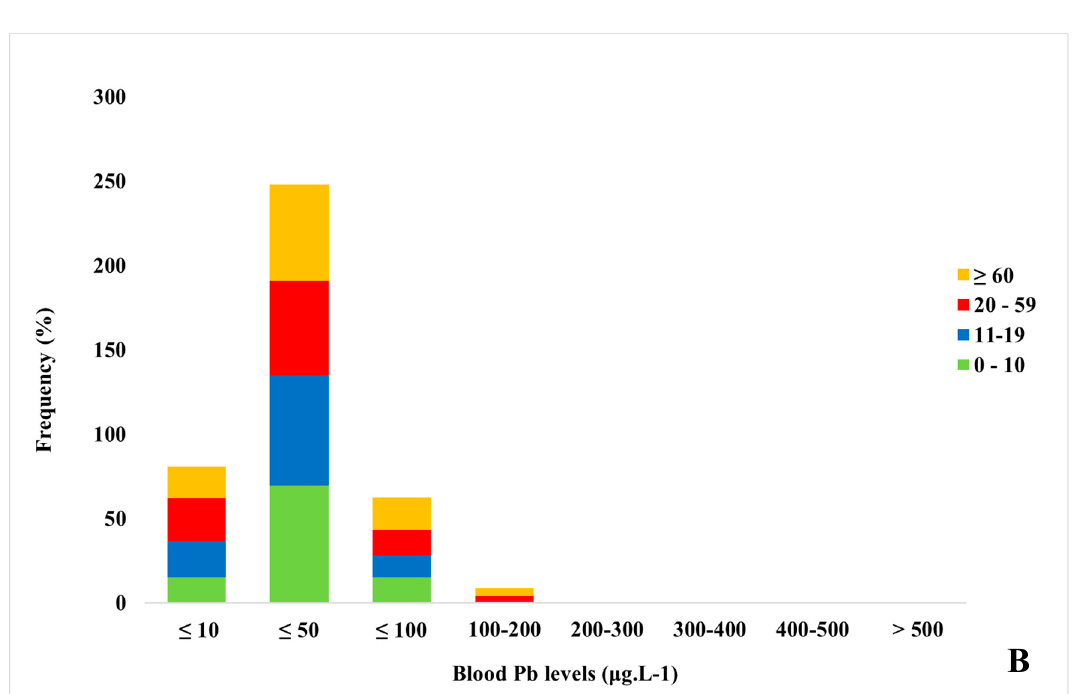
Figure A4. ( A ) Frequency of lead (Pb) blood levels based on the age range in the district of Dom Manuel; ( B ) frequency of blood levels of Pb based on the age range in the district of Laranjal, State of Pará, Brazil.